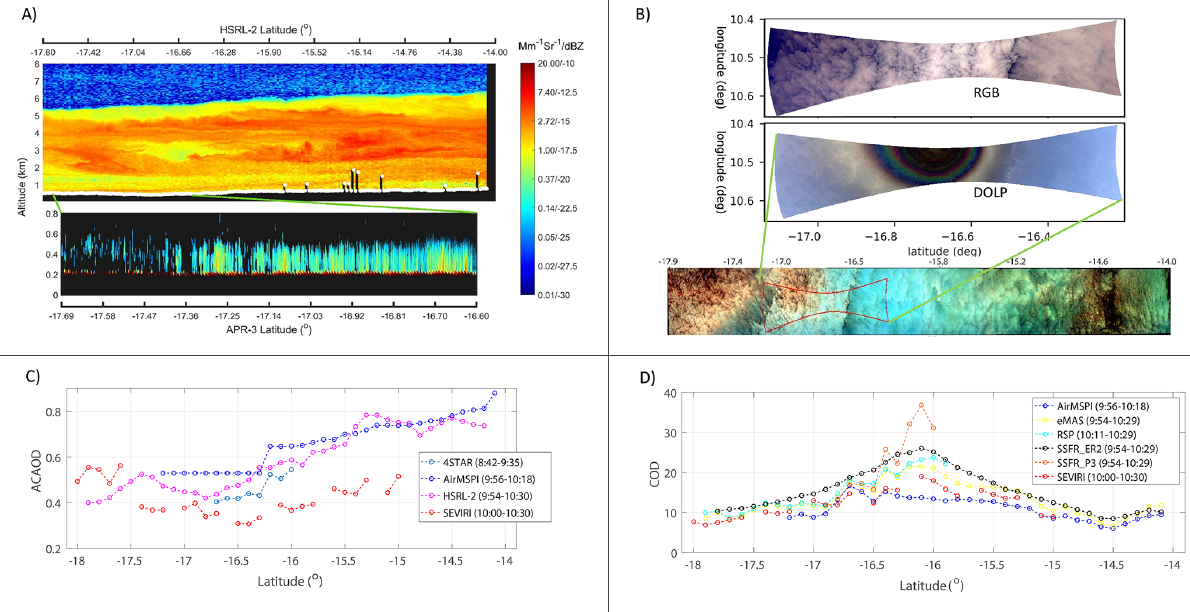
Figure 20. Illustrative remote-sensing observations in ORACLES-2016. (a) Vertical structure of aerosol backscatter and W-band reflectivity from HSRL-2 and APR-3, respectively. (b) Degree of linear polarization (DoLP) and RGB imagery from AirMSPI (bow-tie patterns) and eMAS, respectively. (c) Above-cloud AOD (ACAOD) retrievals from various P-3, ER-2, and satellite instruments. (d) COD retrievals from various P-3, ER-2, and satellite